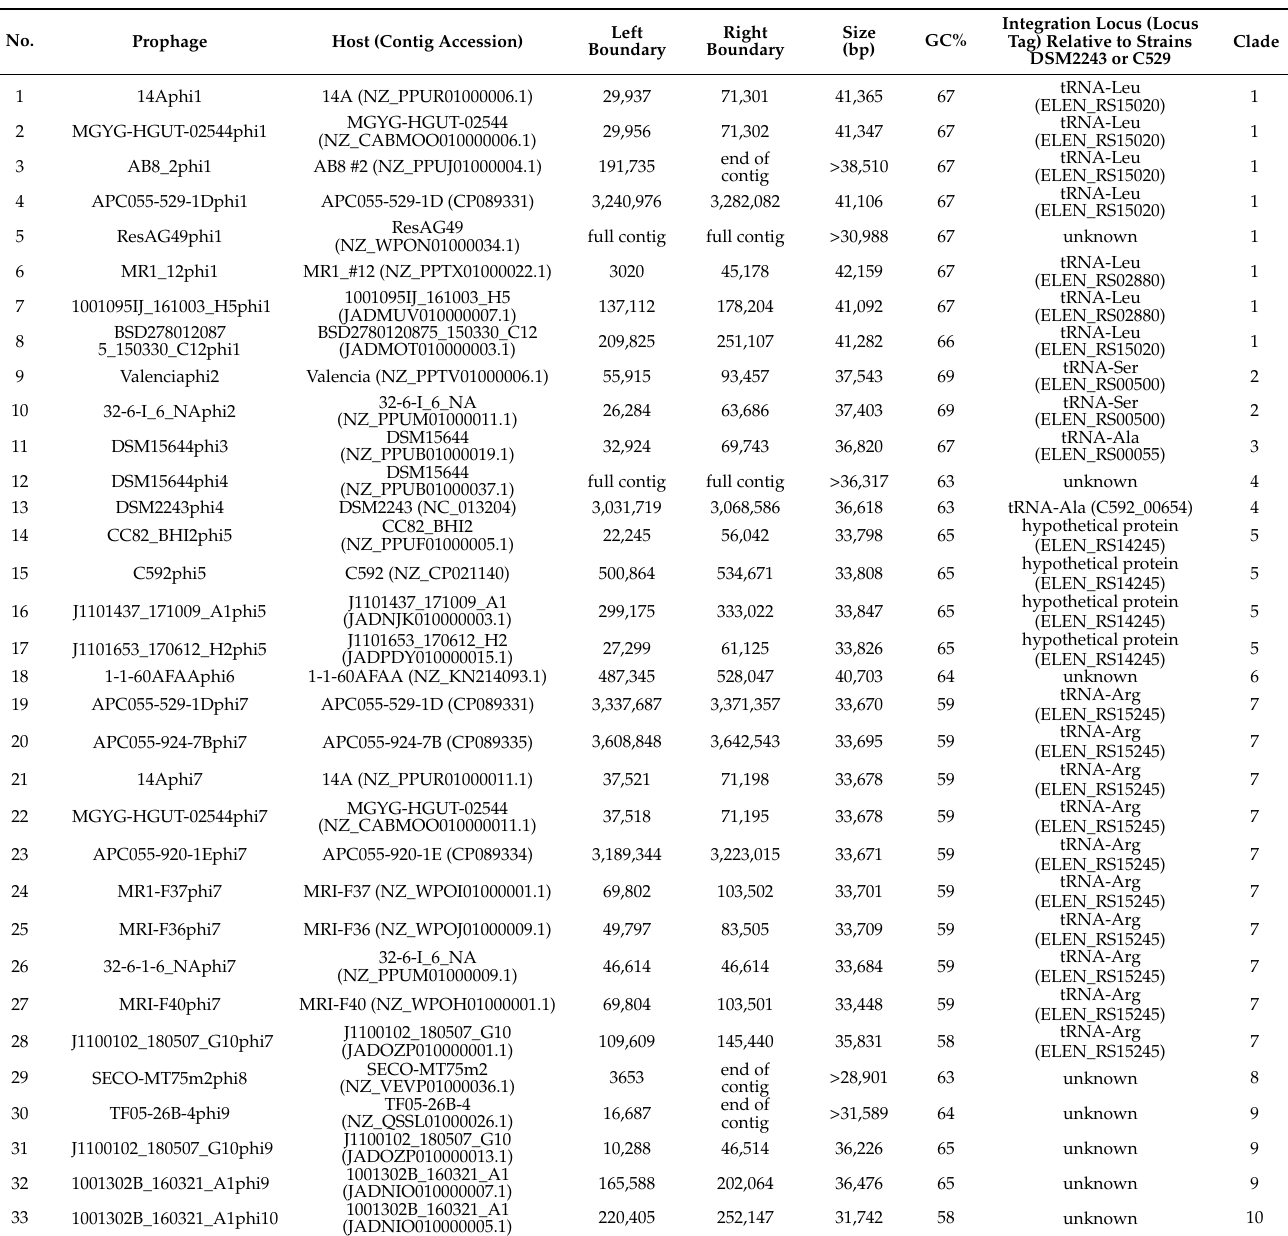
Table 2. General details of identified E. lenta prophage genomes among host